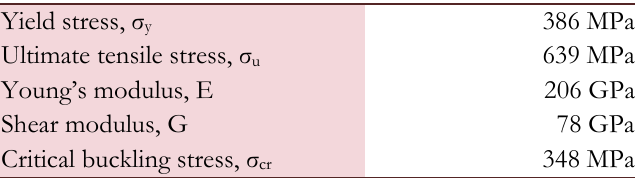
Table 1: Monotonic properties of St52-3N steel.